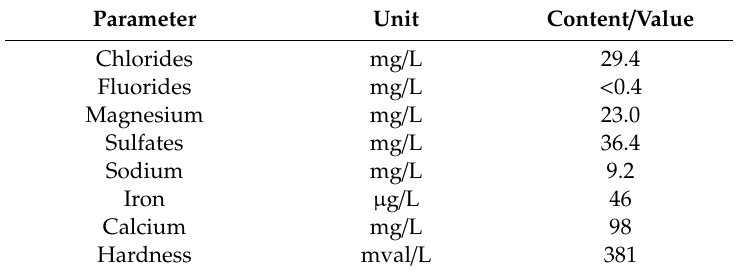
Table 4. Selected physical and chemical parameters of tap water (presented in